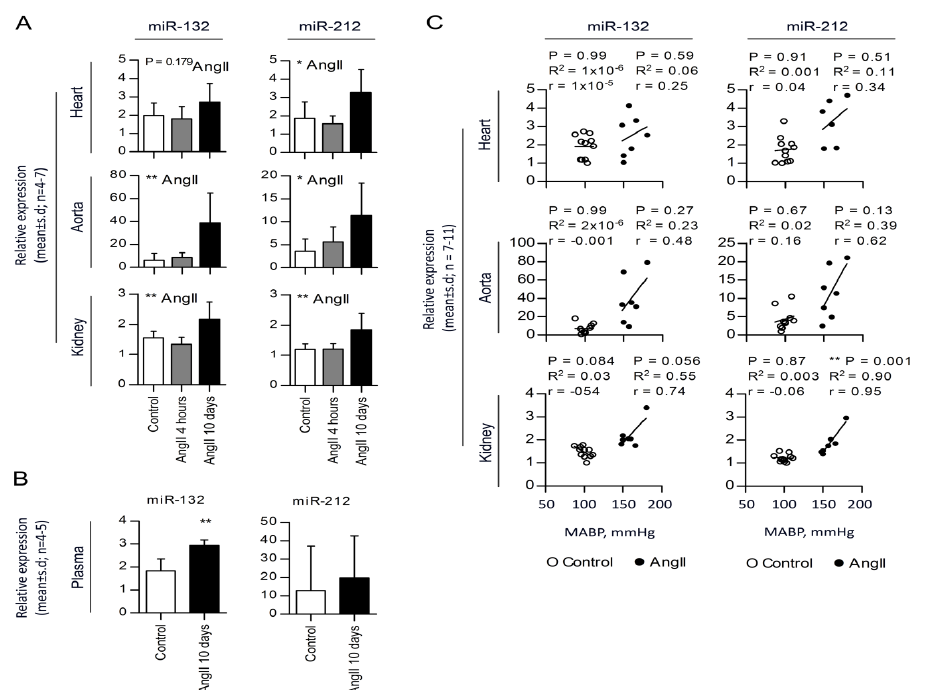
Figure 2. Validation of miRNA regulation in AngII-induced hypertensive rat heart, aorta and kidney. ( A ) qRT-PCR identification of miRNAs in left ventricle of hearts, aortas and kidneys from AngII affected rat hearts. Statistical significance was tested by one way ANOVA. * p < 0.05. Values are shown as relative expression with the mean ± SD; n = 4–7; ( B ) qRT-PCR identification of miRNAs in plasma of AngII affected rat hearts. Statistical significance was tested by un-paired t -test. ** p < 0.01. Values are shown as relative expression with the mean ± SD; n = 4–5. miRNA expression in the three organs and in plasma was individually normalized to two reference genes stably expressed among the samples. Reference genes used for normalization: Heart, miR-17 and miR-191 (M: 0.356, CV: 0.123); aorta, miR-103 and miR-191 (M: 0.832, CV: 0.290); kidney, miR-17 and miR-191 (M: 0.145, CV: 0.050); and plasma, miR-17 and miR-103 (M: 1.143, CV: 0.390); ( C ) Correlation analysis for miRNA expression levels at day 10 of AngII or isotone glucose infusion. Statistical significance was tested by linear regression ( R 2 ) and correlation analysis (Pearson’s r ). Data are shown as two individual correlations per miRNA is each organ for control ( ○ ) and AngII for 10 days ( ● ). ** p < 0.01; n =